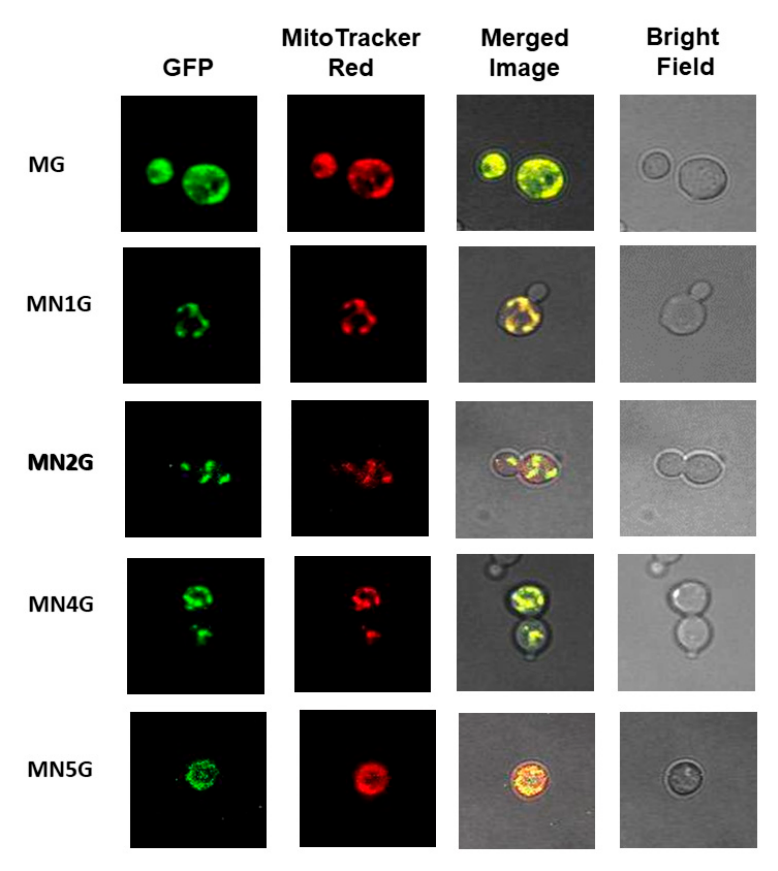
Figure 7. Subcellular localization of MT-EGFP, MT-Nad1-EGFP, MT-Nad2-EGFP, MT-Nad4-EGFP, and MT-Nad5-EGFP fusion proteins after expression in yeast observed with fluorescence microscopy. Yeast cells of MG, MN1G, MN2G, MN4G, and MN5G were incubated in SC-U medium plus 2% galactose for 15 h at 30 °C to generate an EGFP signal. Green fluorescence indicates the mitochondria containing EGFP, red fluorescence indicates the mitochondria labeled with MitoTracker Red, and the yellow regions in the merged images indicate the co-occurrence in the mitochondria. The integrity of the cells was monitored by bright-field microscopy.